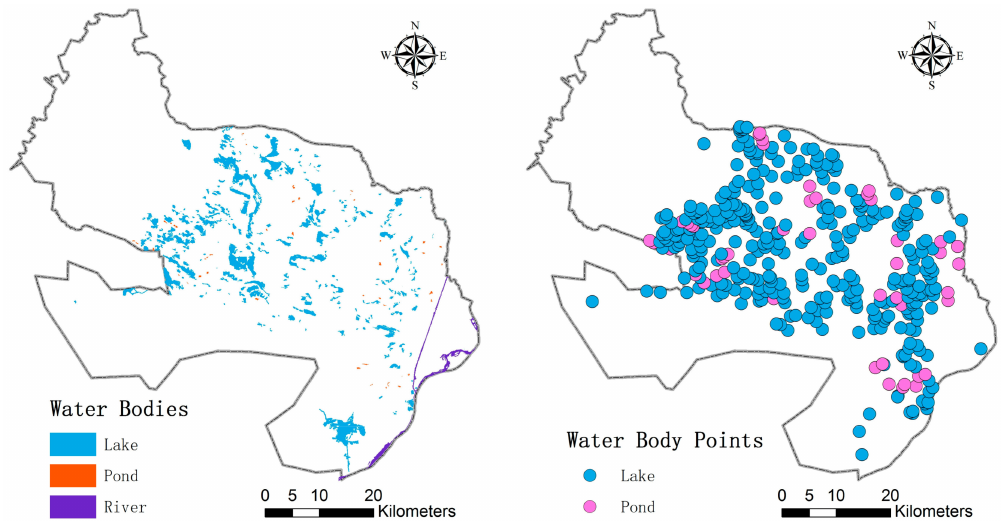
Figure 13. Spatial distribution of surface water bodies and nodes.